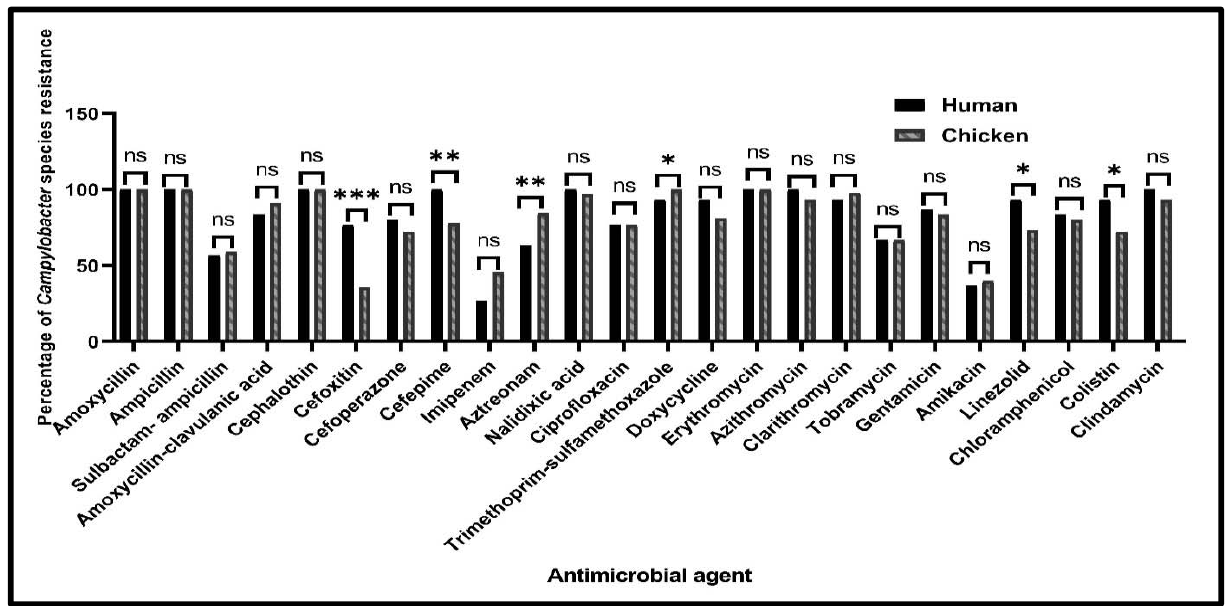
Figure 1. Prevalence of Campylobacter jejuni and Campylobacter coli resistance against 24 antimicrobial agents. ns: non- significant, * p < 0.05, ** p < 0.01.